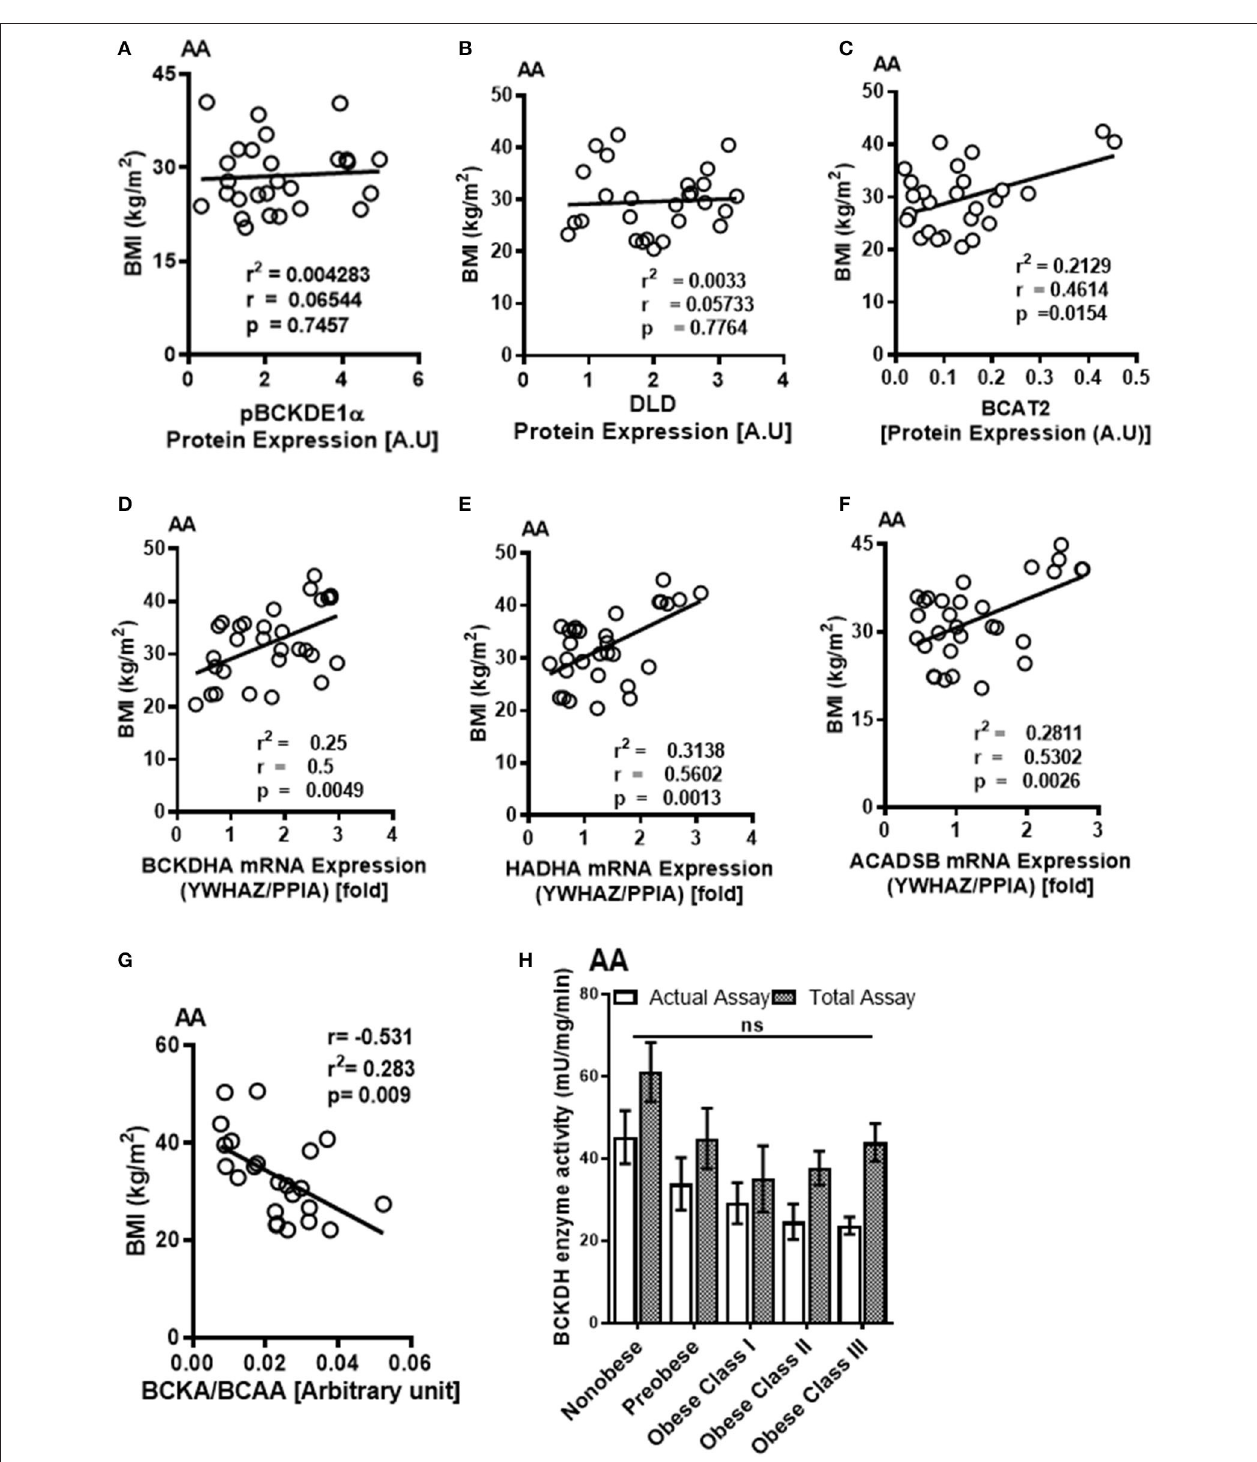
FIGURE 5 | Increased mRNA expression of BCAA catabolic enzymes and altered BCKA to BCAA levels in the AA of cardiac surgery patients with obesity are associated with BMI. Linear regression of (A) pBCKDE1 α , (B) DLD, and (C) BCAT2 protein expression in the AA tissues of non-obese ( n = 7), pre-obese ( n = 7), class I obese ( n = 8) and class II obese ( n = 6) cardiac surgery patients correlated with BMI. Linear regression of (D) BCKDHA , (E) HADHA , and (F) ACADSB mRNA expression in the AA tissues of non-obese ( n = 6), pre-obese ( n = 6), class I obese ( n = 6), class II obese ( n = 6) and class III obese ( n = 6) cardiac surgery patients correlated with BMI. (G) Linear regression of the intramyocellular BCKA to BCAA ratio of non-obese ( n = 5), pre-obese ( n = 5), class I obese ( n = 5), class II obese